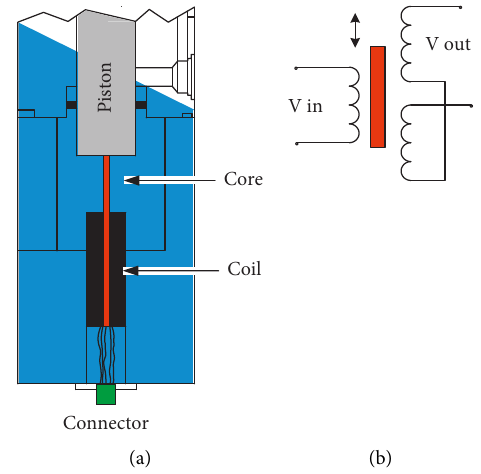
Figure 2: Sketch map of sensors. (a) LVDT. (b) Load cell.